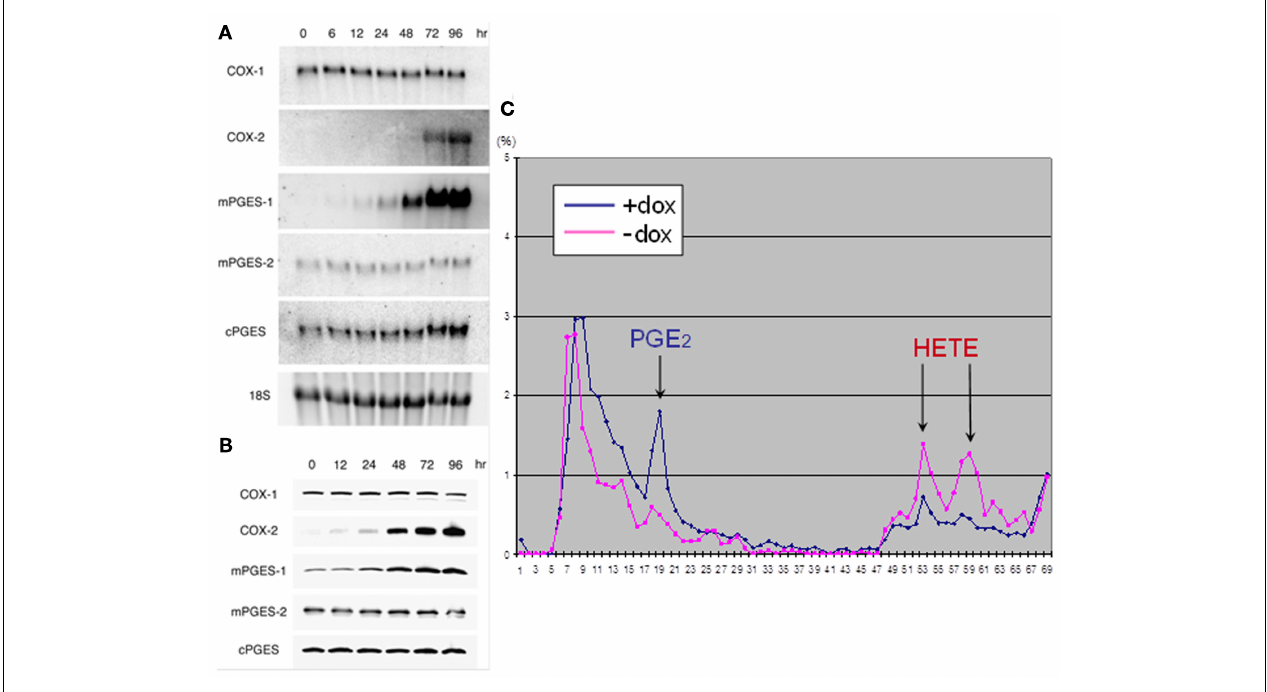
RET/PTC3 expression for up to 96h induces COX-2 and mPGES-1 protein but not COX-1, mPGES-2, or cPGES. (C) HPLC analysis of conditioned medium of PTC3-5 cells metabolically labeled with [3H]arachidonic acid showing that doxycycline (DOX) treatment induces PGE 2 synthesis and secretion in the medium [modified from Puxeddu et al.